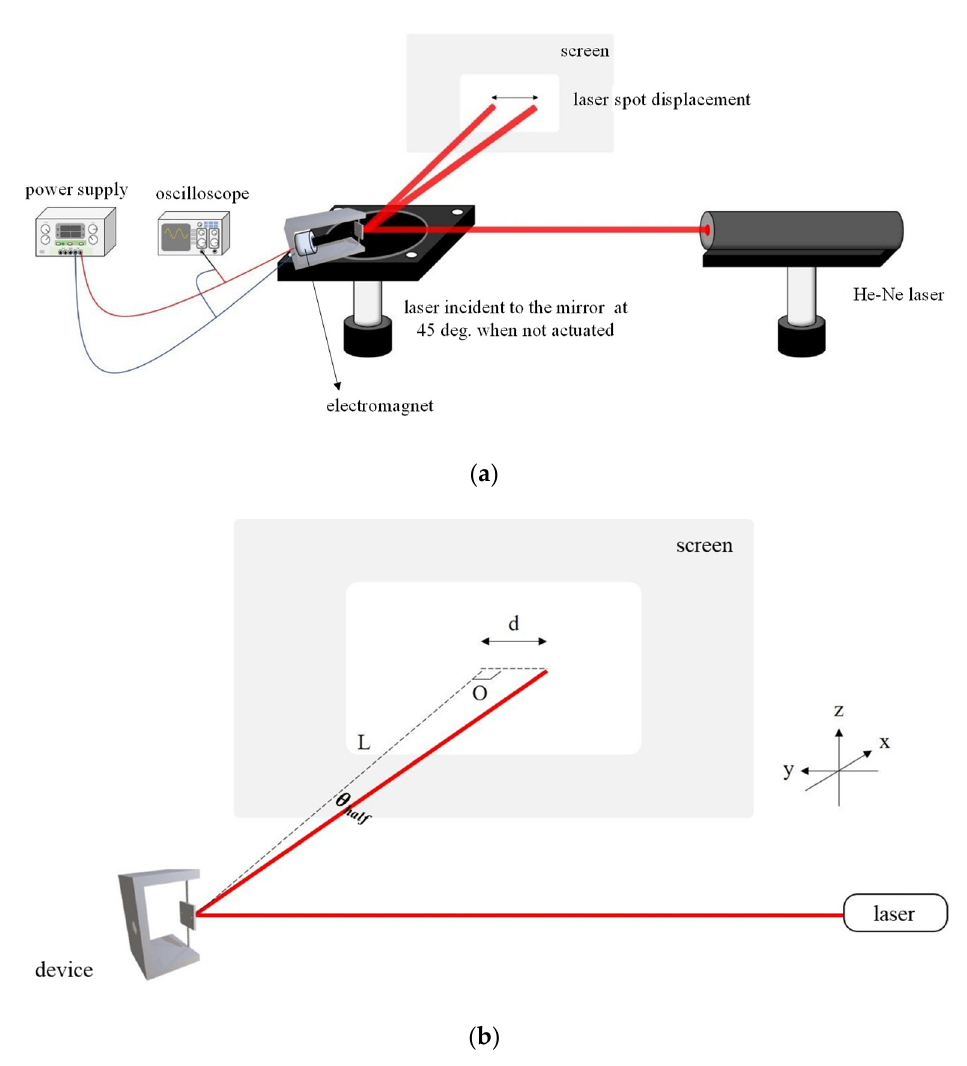
Figure 4. dc characterization: ( a ) experimental setup; ( b ) the optical half angle ( θ half ) can be found using the given L and measured d.